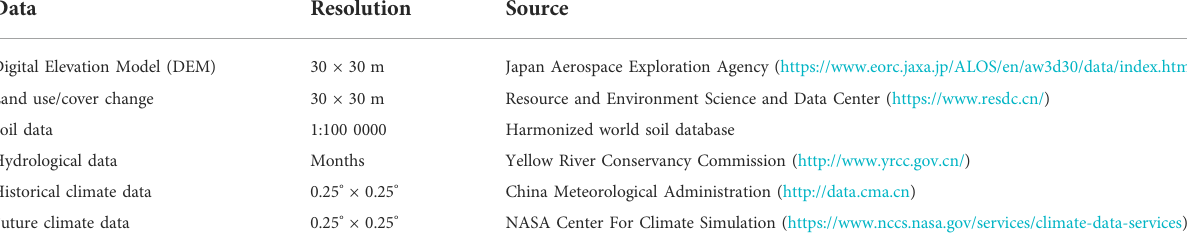
TABLE 1 Detailed information of the